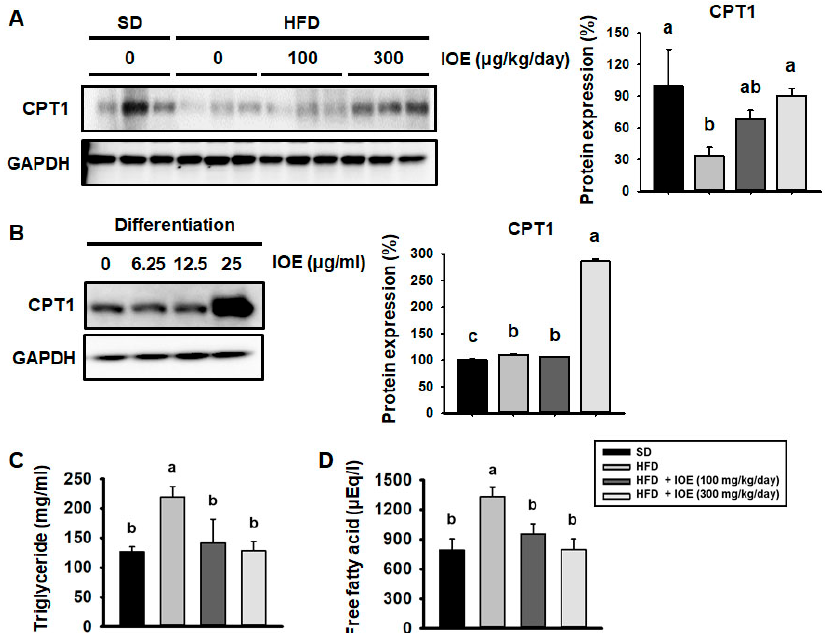
Figure 5. IOE increases the expression of carnitine palmitoyltransferase I (CPT1) in 3T3-L1 adipocytes and the WAT of HFD-induced obese mice, and reduces circulating TG and FFA concentrations. ( A ) Representative western blot showing CPT1 expression in WAT after 6 weeks of HFD feeding ± IOE administration. ( B ) Western blotting for CPT1 level in 3T3-L1 cells after differentiation ± IOE administration for 8 days. ( C , D ) Serum levels of TG and FFA were measured after 6 weeks of HFD feeding ± IOE administration. Data are expressed as mean ± S.D ( n = 6). Values with different letters are significantly different; p < 0.05 (a > b).